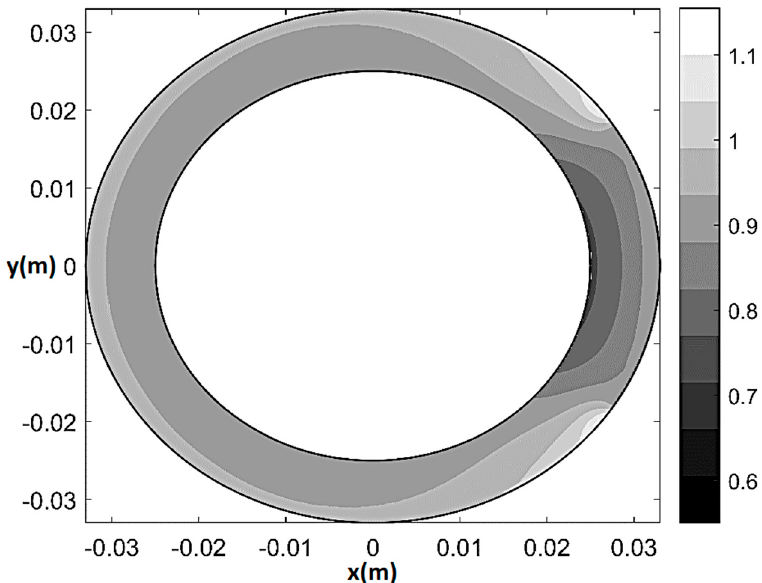
Figure 8. Normalized flow rate ( U / U H ) contour plot under stress for 80% CX stenosis ( q 0 = q 0 H = 2.7 × 10 − 9 m 2 /s, T / T H = 0.8055, ξ = 0.55, Θ s = 72°, δ given by (28)).